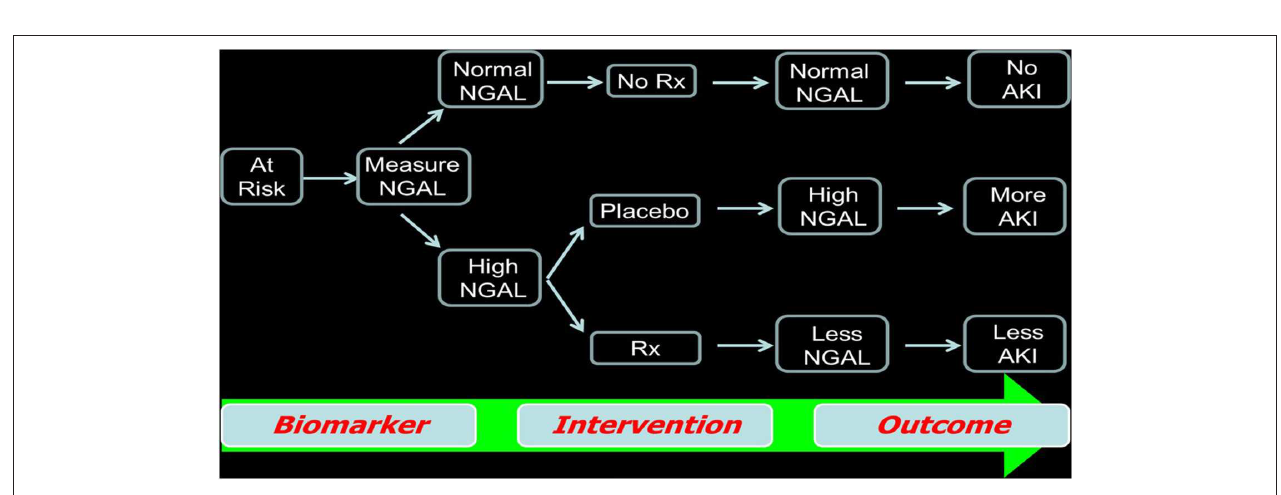
FIGURE 2 | Use of biomarkers as criteria for enrollment in randomized clinical trials as well as to assess the efficacy of the agent being